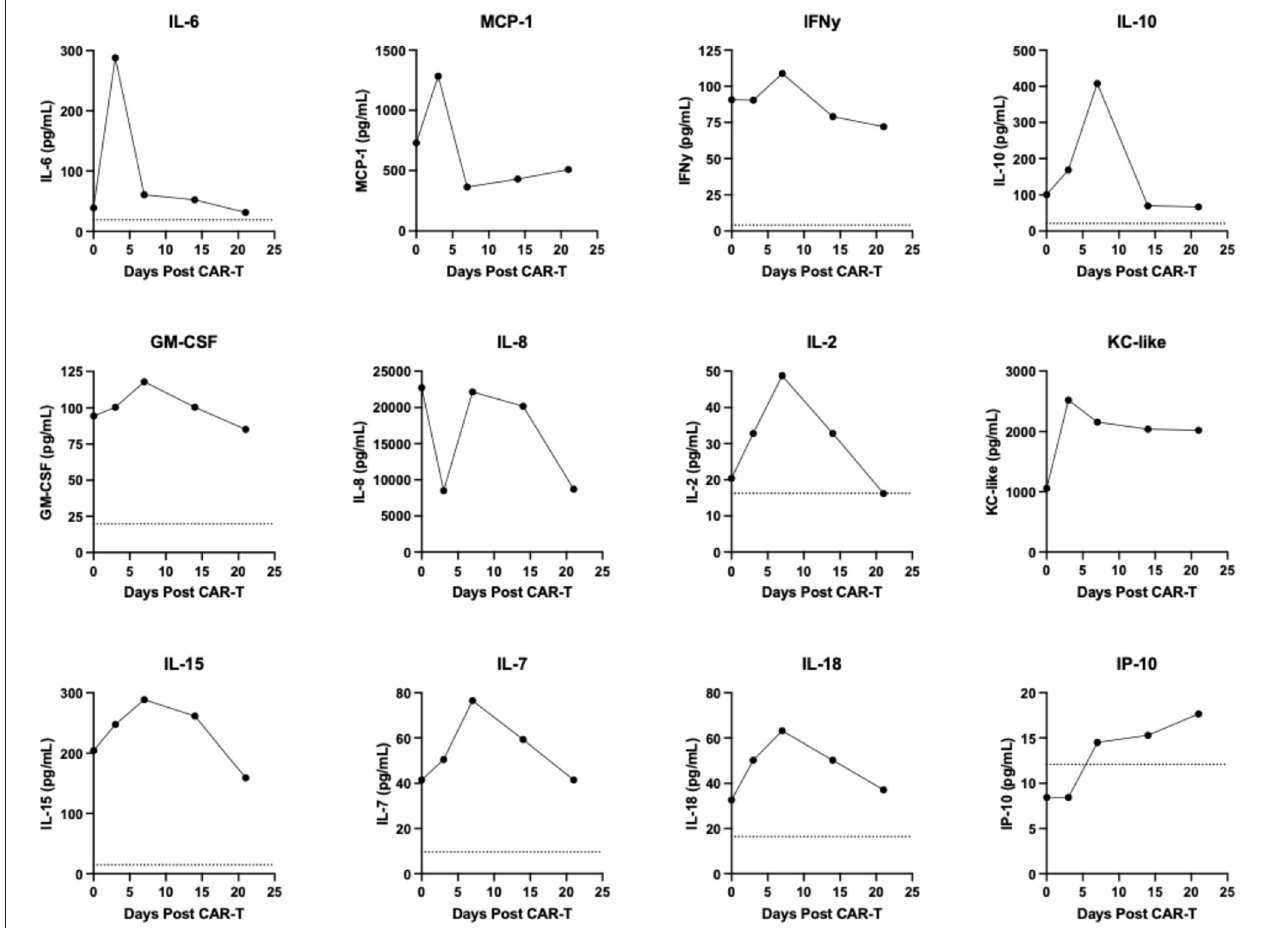
FIGURE 4 | Serial multiplexed analysis of serum cytokines. Dashed lines represent lower limits of detection, dashed lines are superimposed with x -axes for those plots where they are not